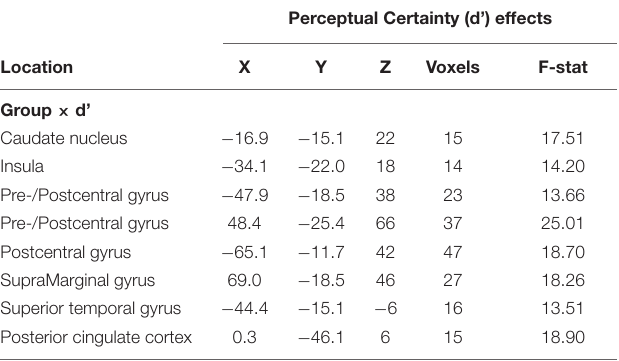
TABLE 5 | Group × Perceptual certainty